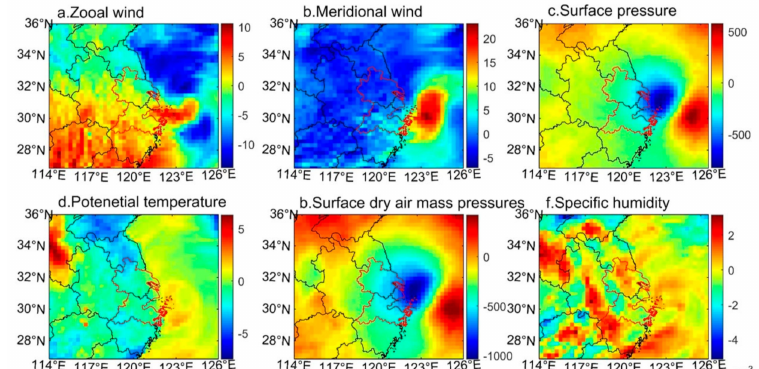
Figure 6. The increments of several variables at the lowest model level from 4D-Var assimilated 6h accumulated precipitation of IMERG-L at 0600 UTC 16 Aug 2018 for TC Rumbia: ( a ) zonal wind (m / s), ( b ) meridional wind (m / s), ( c ) surface pressure (Pa), ( d ) potential temperature (K), ( e ) surface dry air mass pressure (Pa), and ( f ) specific humidity (kg /